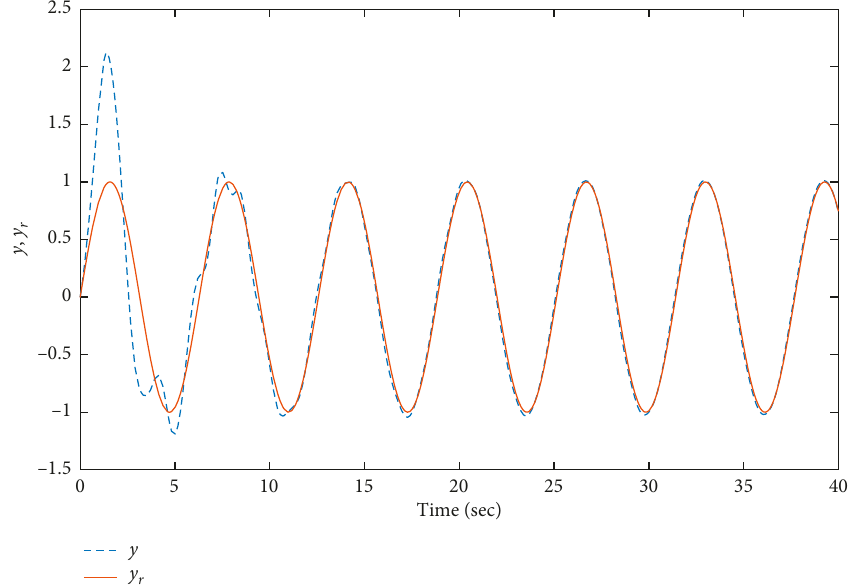
Figure 1: The reference signal y